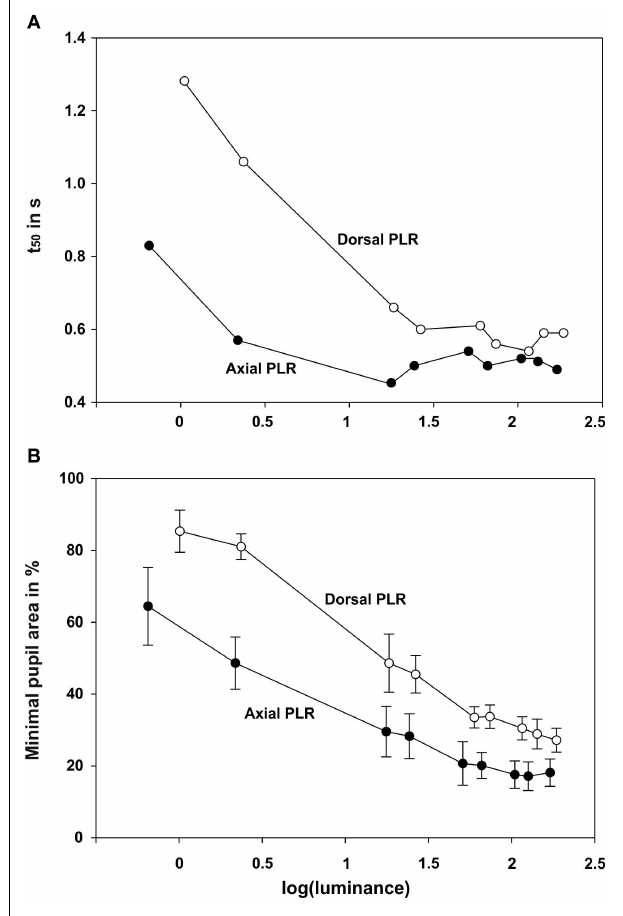
FIGURE 3 | Summary graphs showing for the pupillary light reaction with dorsal and axial illumination A the t 50 value (in s) and B minimal pupil area (in % of the maximum pupil area at light onset) as a function of log